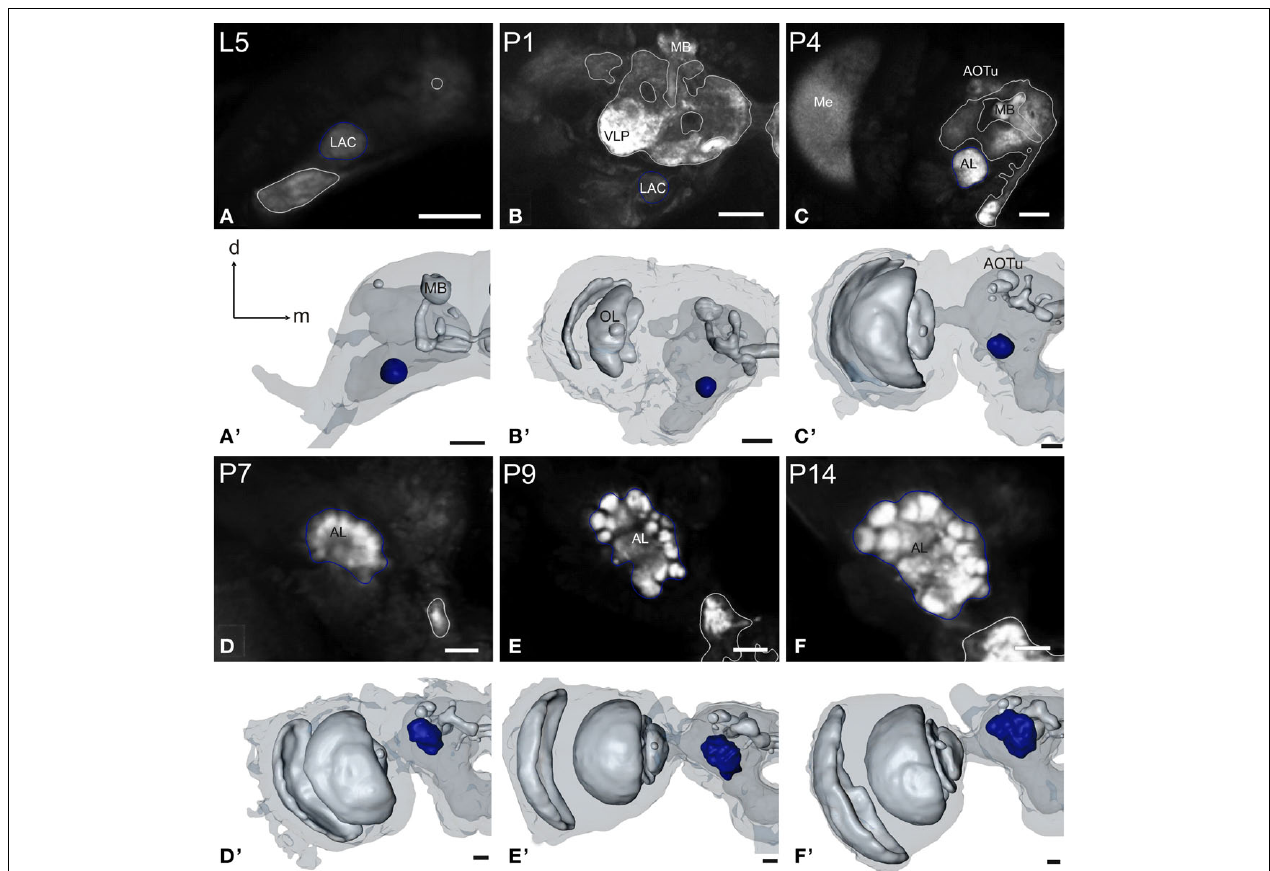
anti-synapsin staining. Note the ventral position of the AL compared to stage P7. (D–D ′ ) Stage P7: glomerular structures surrounding a coarse neuropil become fi rst visible. (E–E ′ ) Stage P9: single glomeruli become discernible structures and achieve their fi nal position within the AL. The dorsal migration of the AL ends. (F–F ′ ) Stage P14: glomerular and AL volume increased compared to stage P9. Orientation bars: d, dorsal; m, medial; all scale bars: 100